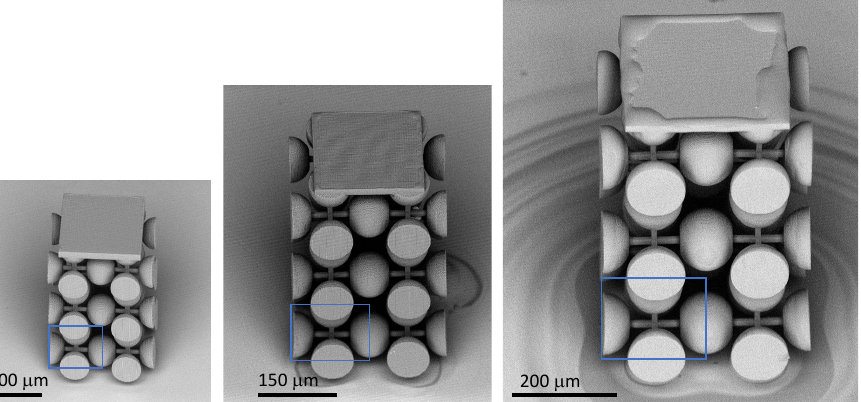
Figure 3. Scanning electron microscope images of the fabricated micro-phononic structures with unit cells of 100 µm, 150 µm and 200